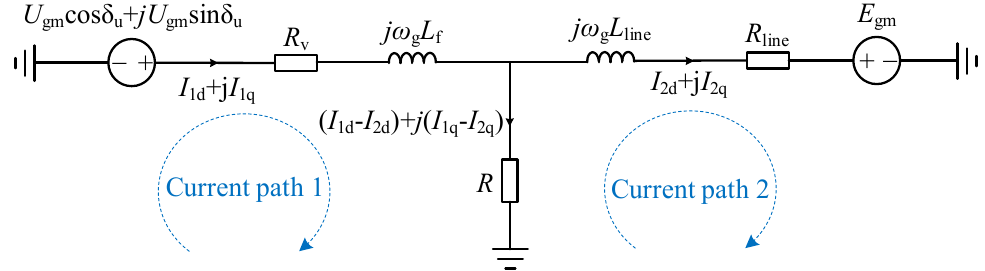
Figure 7. Equivalent circuit diagram of the grid-connected wind turbine system with virtual resistor control in the dq frame after the three-phase short-circuit fault occurs.